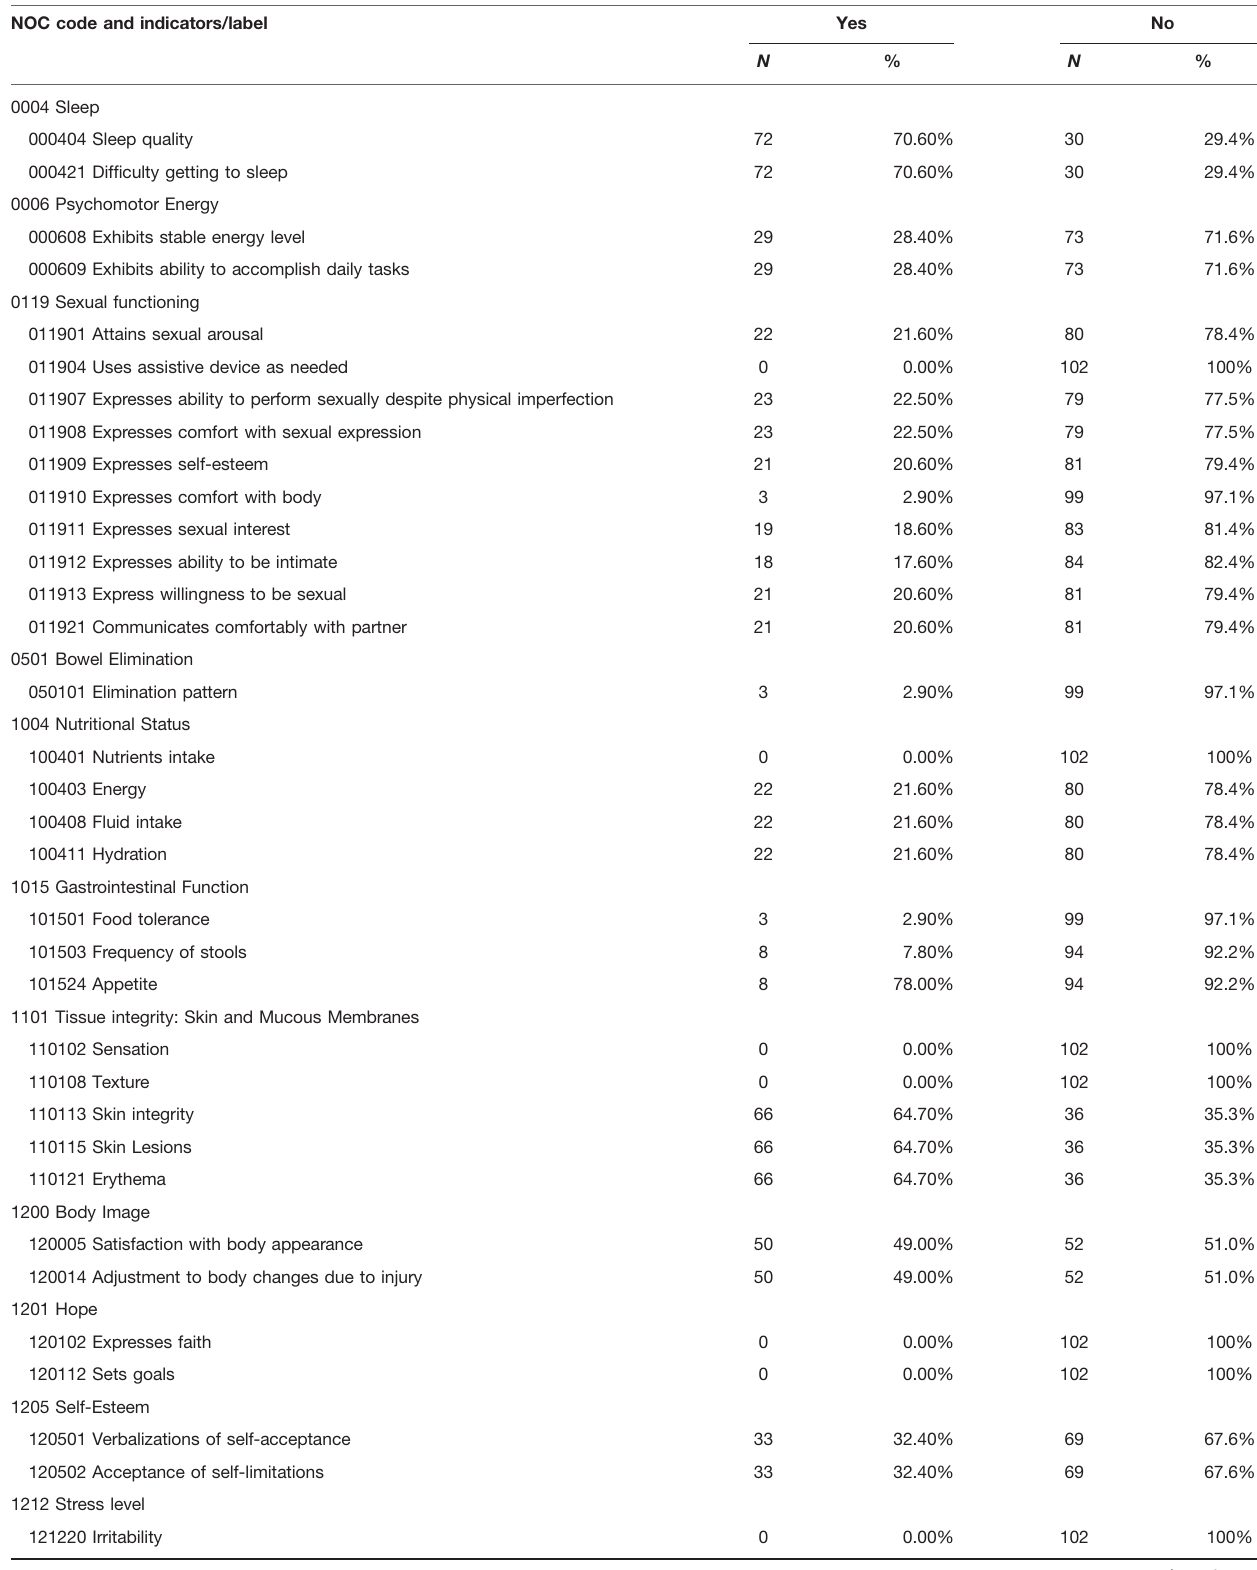
TABLE 2 | Distribution of NOC outcomes and their